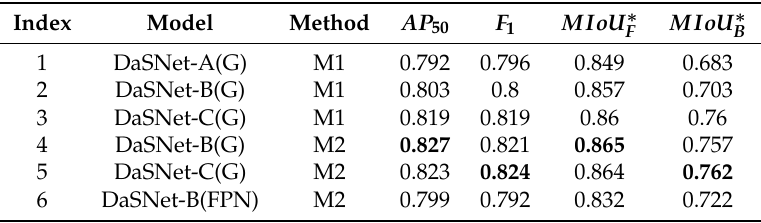
Table 2. Experiment on DaSNet architectures and training methods (G stand for the GFPN) ( ∗ F stands for fruit, B stands for